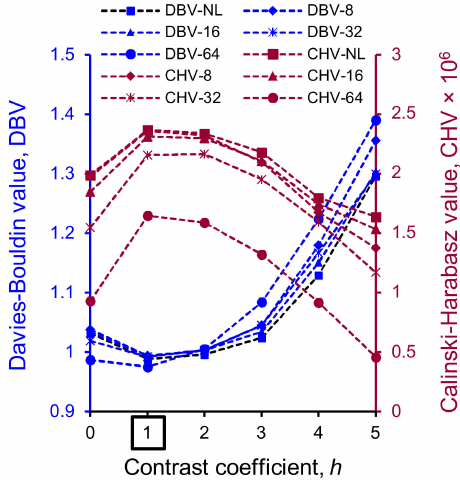
Figure 2. Variation of cluster evaluation criteria values with contrast coefficients ( h -values) at different vertical stresses (square marked h -value represents the optimal condition; NL: